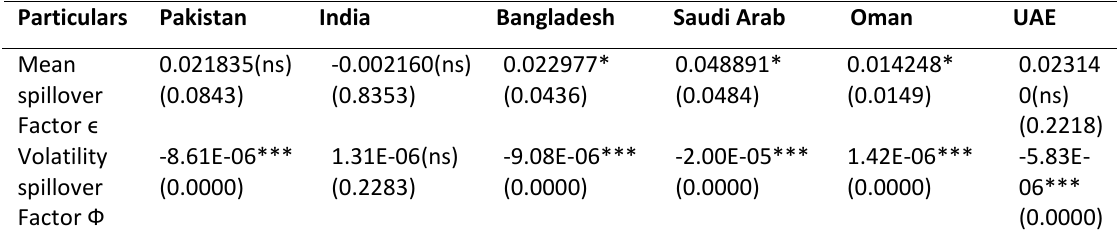
Table 7. Consolidated reporting of